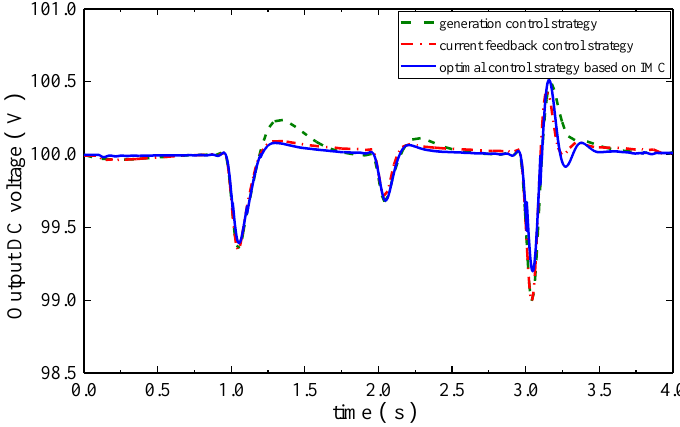
Figure 8. Comparison of mean voltage of three control strategies.